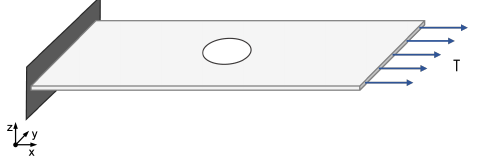
Figure 8. Schematic representation of the